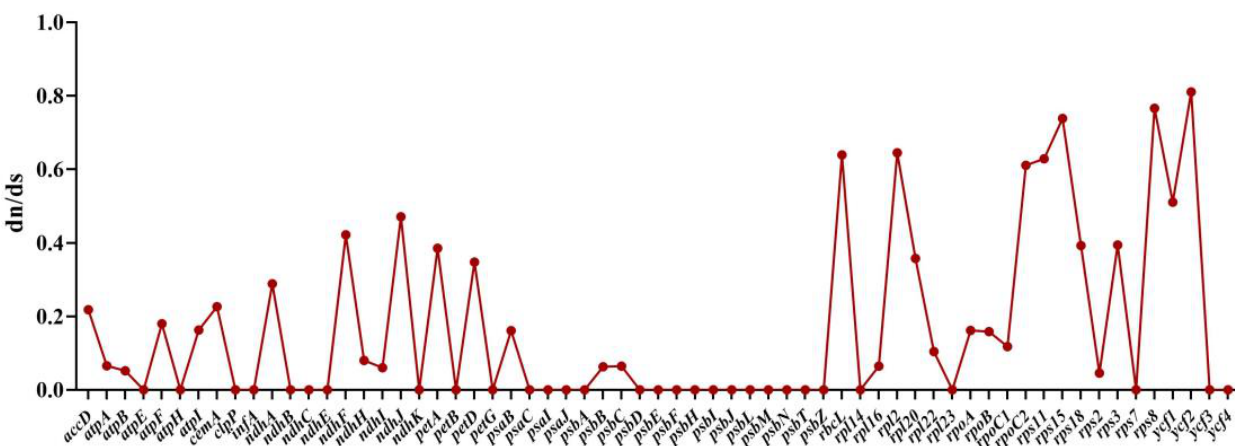
Figure 10. The dN/dS ratio values of common protein-coding genes in five Uncaria species chloro- plast genomes.